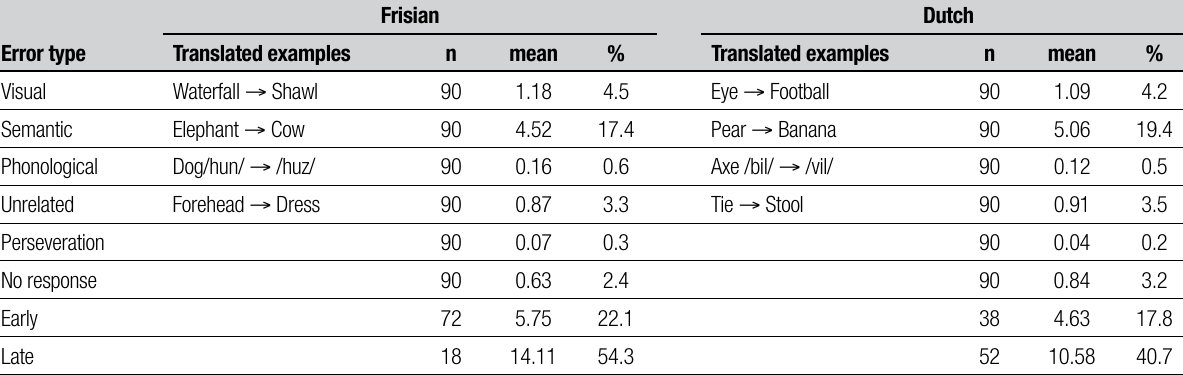
Table 3. Classification and distribution of errors across Frisian and Dutch for early and late